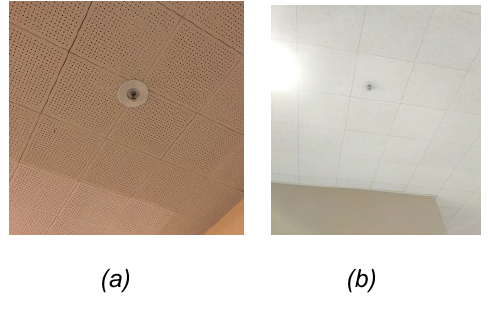
Figure 7. Fire sprinklers from Cory Hall (a) from training set; (b) undetected and misclassified fire sprinkler from round 5.